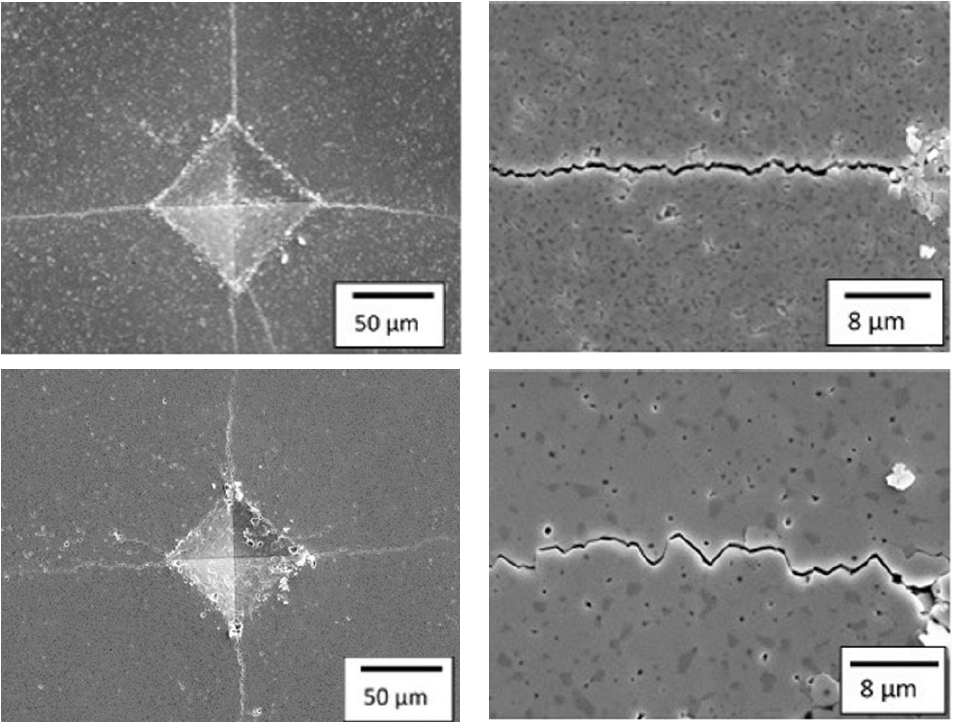
Fig. 10 Vickers imprint and crack path in ZrC samples: calculated K Ic = 2.8 MPa·m 1/2 for ZC1-2.6 sintered at 1850 ℃ with maximum grain size of 1 µm (upper pictures), and calculated K Ic = 4.1 MPa·m 1/2 for ZC1-2.6 sintered at 2000 ℃ with maximum grain size of 5 µm (lower